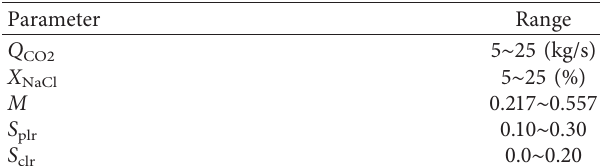
Table 2: The range of reference parameters.